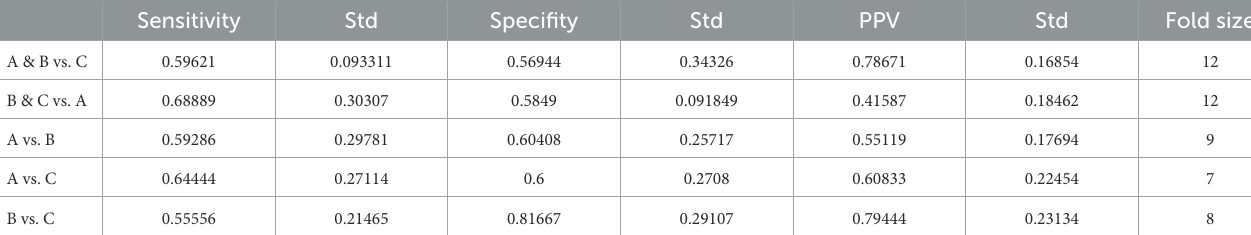
TABLE 1 Results of cross-validation.